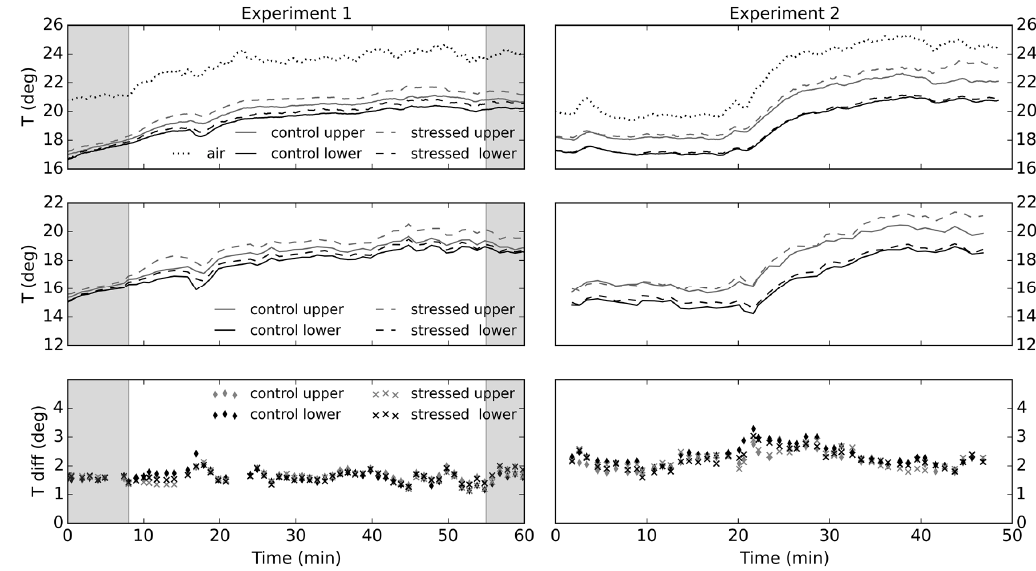
Figure 7. Temperature readings acquired by the thermocouples ( top ); and the thermal camera ( middle ) for the lower and upper parts of tree crowns; and differences between the two ( bottom ). Experiment 1 involved a moderately, whilst Experiment 2 a mildly stressed tree. Shaded areas indicate times at which the additional light sources were turned off.